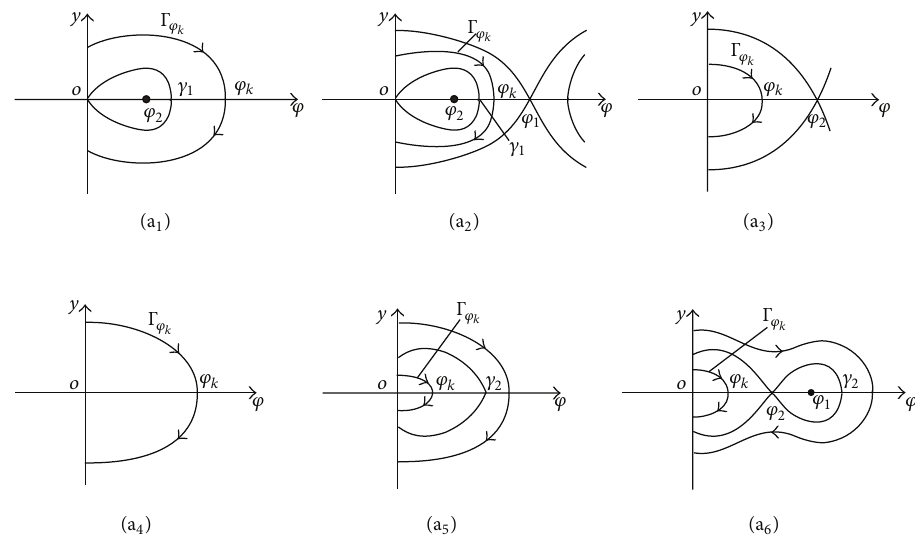
Figure 5: The graphs of orbit Γ 𝜑 𝑙 (𝑎 > 0) , (a 𝛿 < 0 and (𝑎,𝑏) ∈ 𝐴 𝐴 6 or 1 4 )